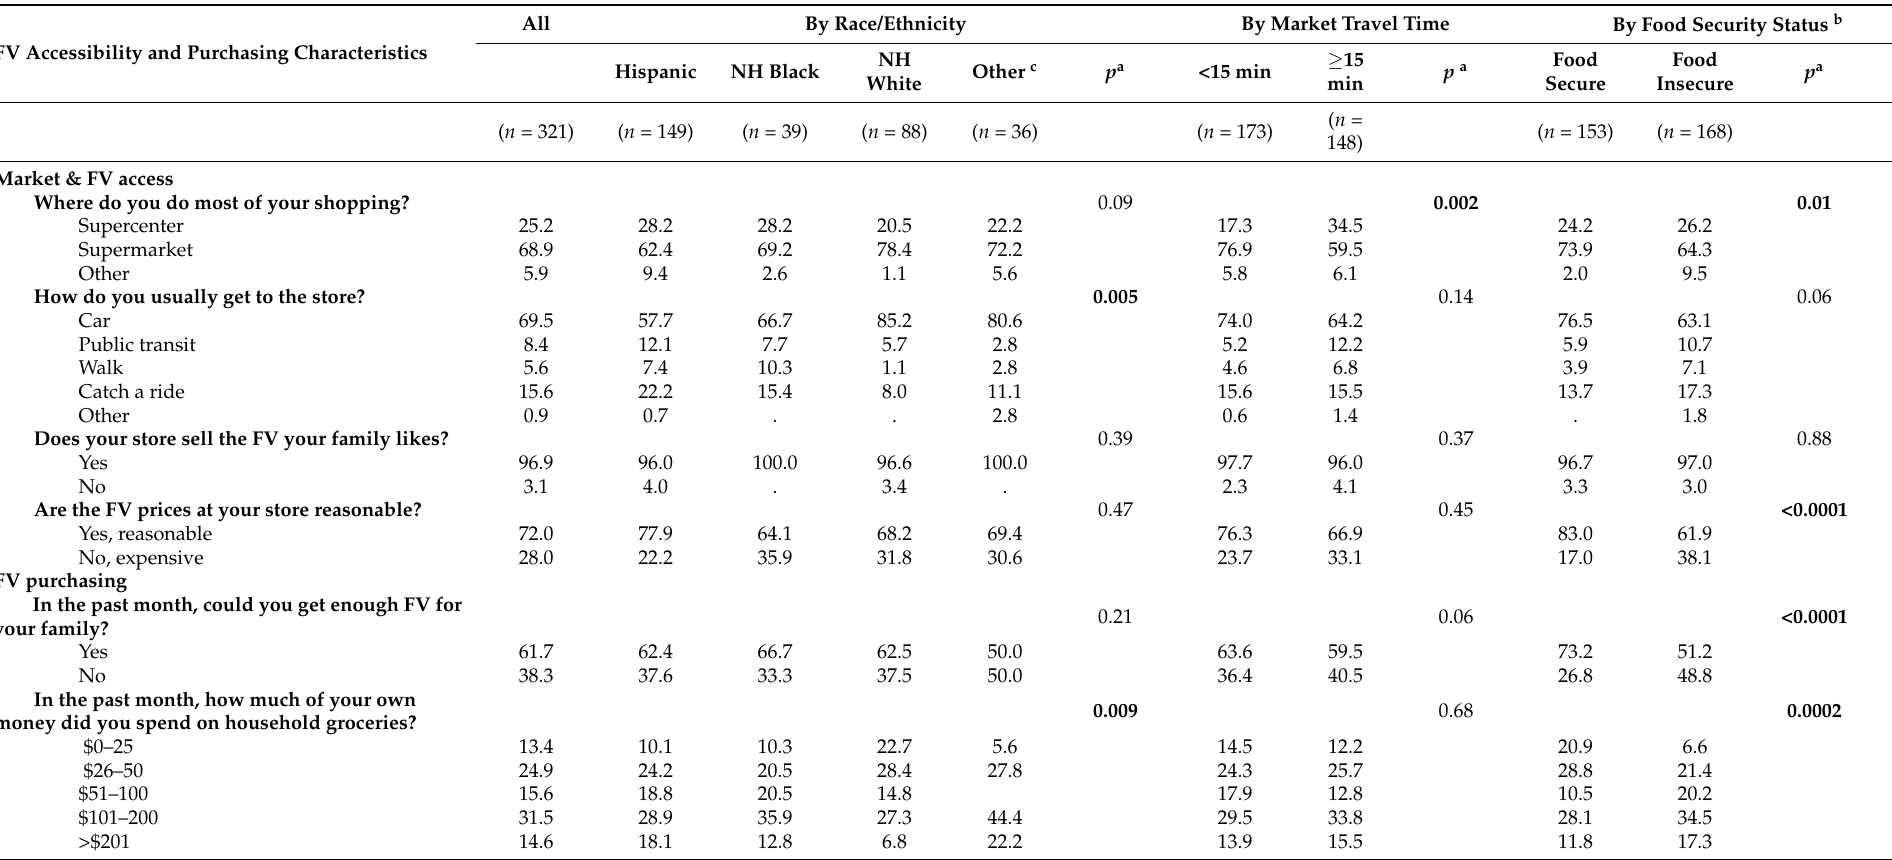
Table 2. MA WIC Caregiver Perceptions of FV Accessibility and Purchasing Post-CVB-Increase by Race/Ethnicity, Average Market Travel Time, and Food Security